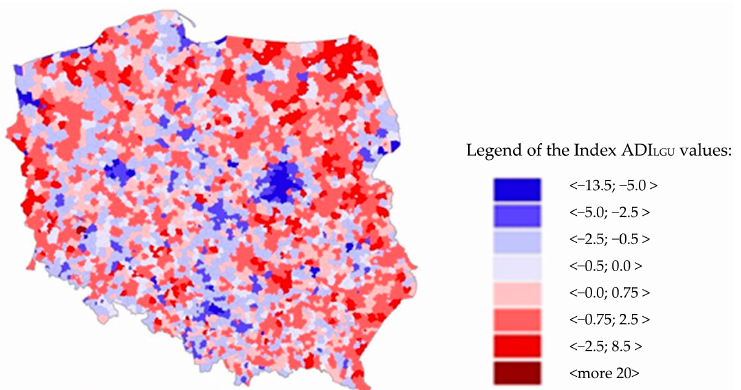
Figure 1. The variation of the value of the Aggregated Development Index municipalities in Poland